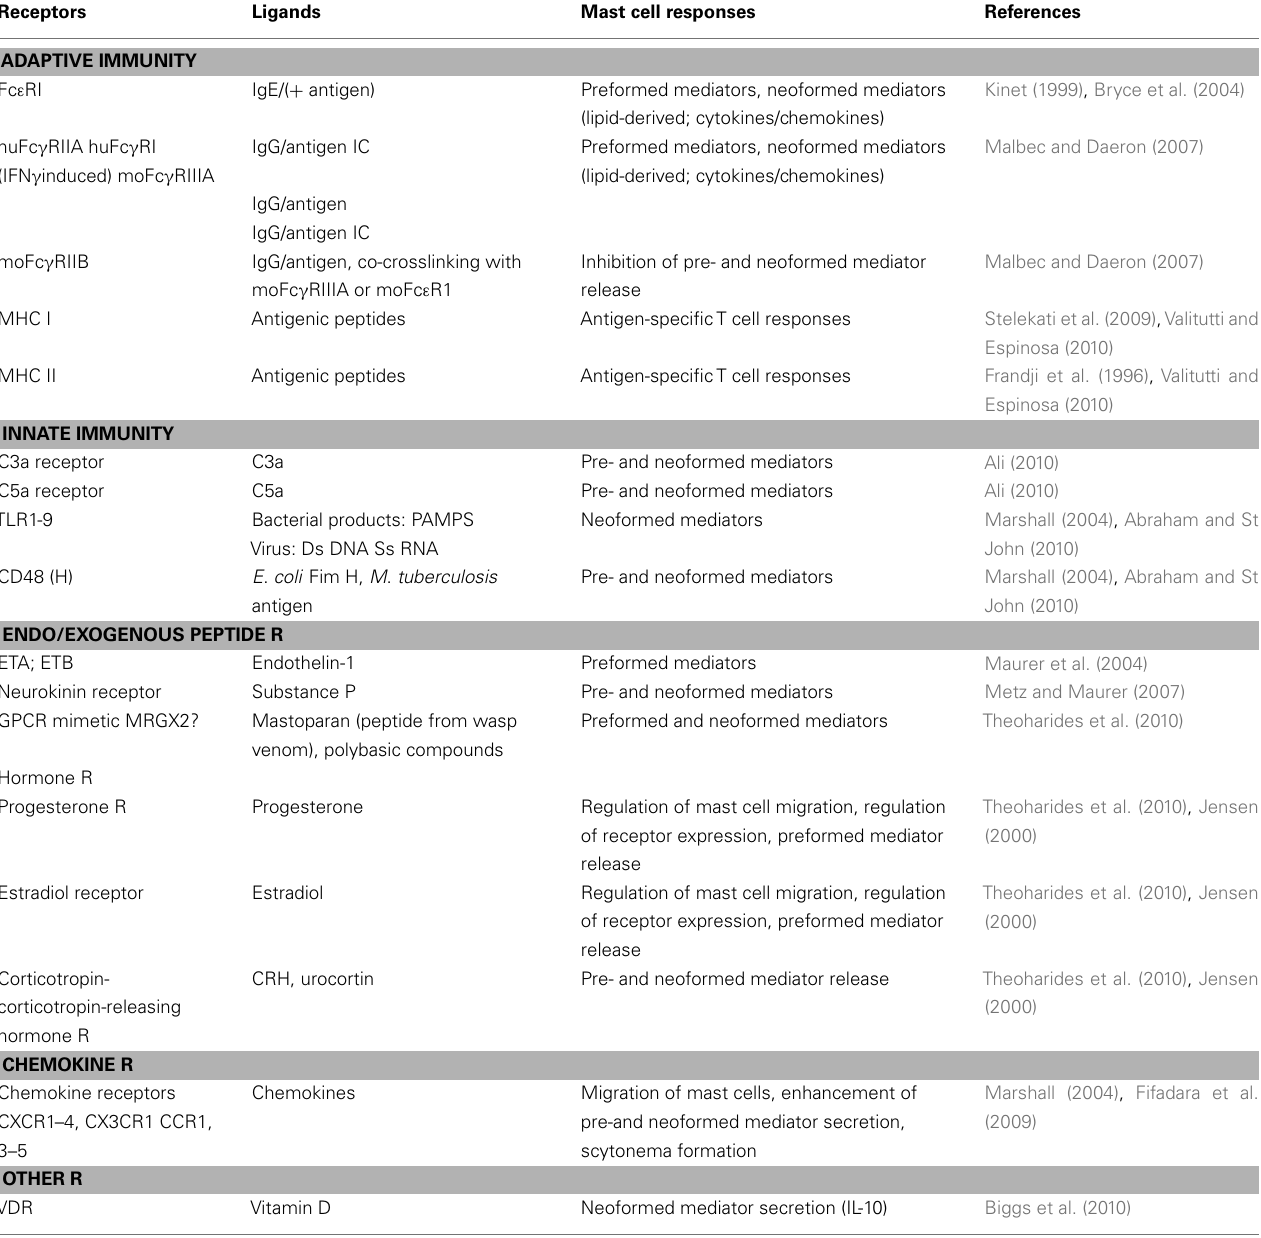
Table 2 | Some of the receptors (R) expressed by mast